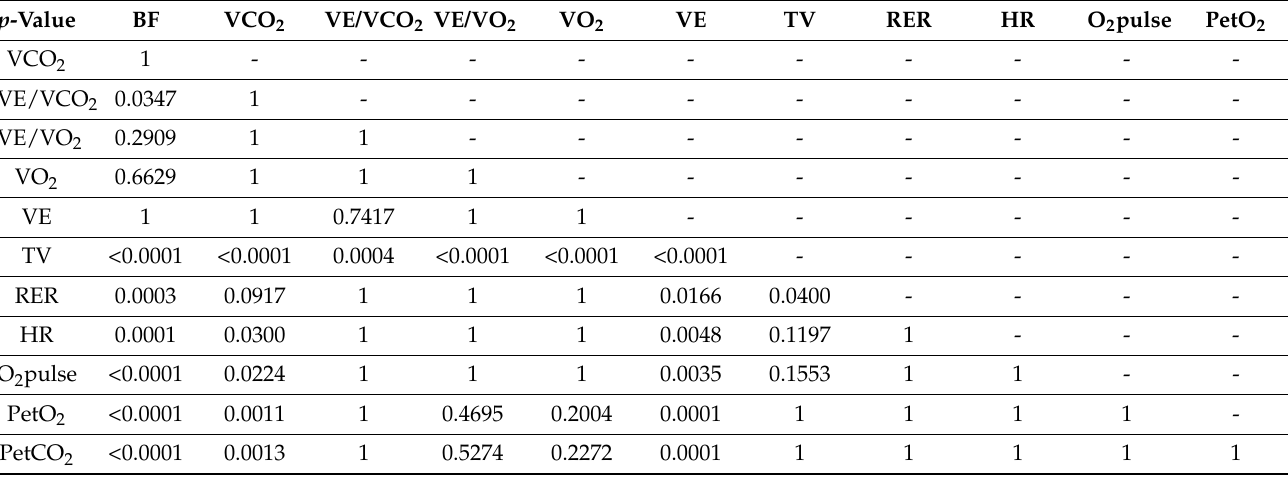
Table 5. Comparison of relative changes of CPET parameters from CPET2 (run with vAT with +12 kg weight vest) and CPET1